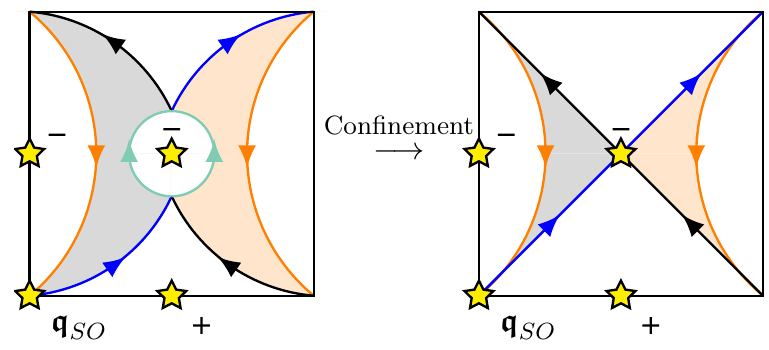
Figure 21. Reconfining the result of Higgsing the deconfined q